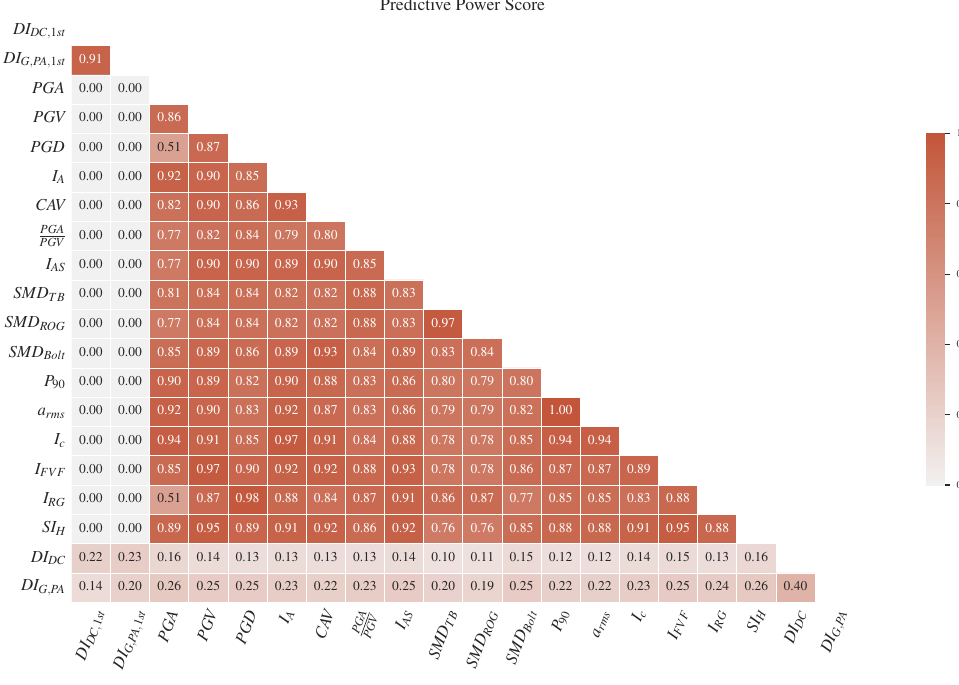
Figure 7. Heatmap of Predictive Power Score (PPS) for every pair of the examined variables including input features and